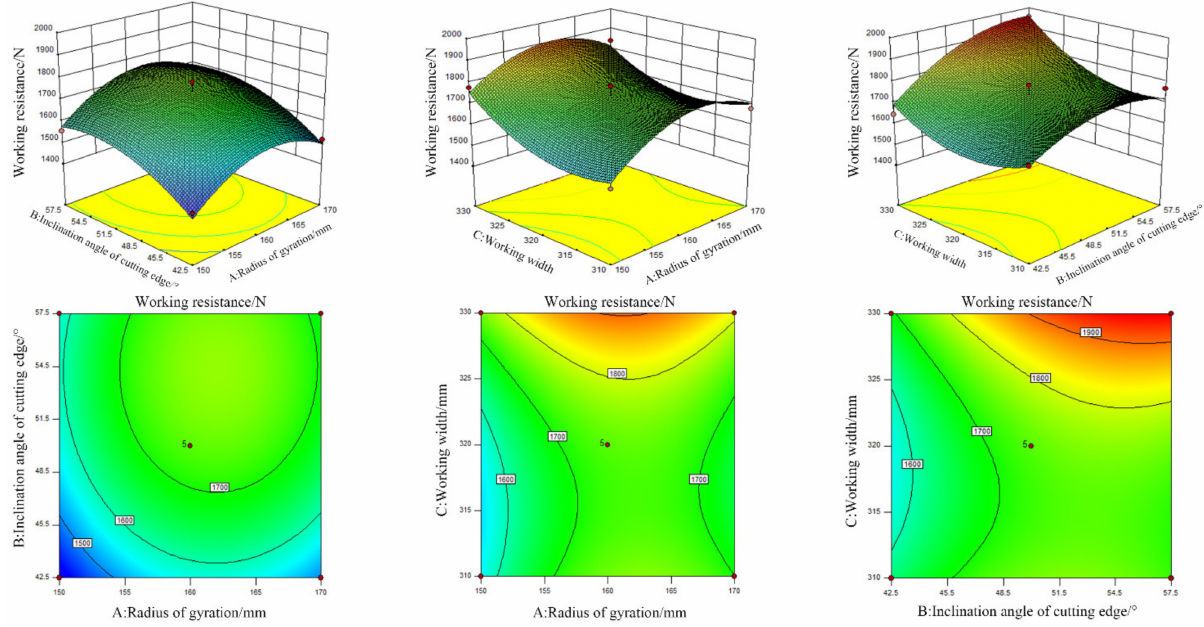
Figure 17. The response surface of each test factor to working